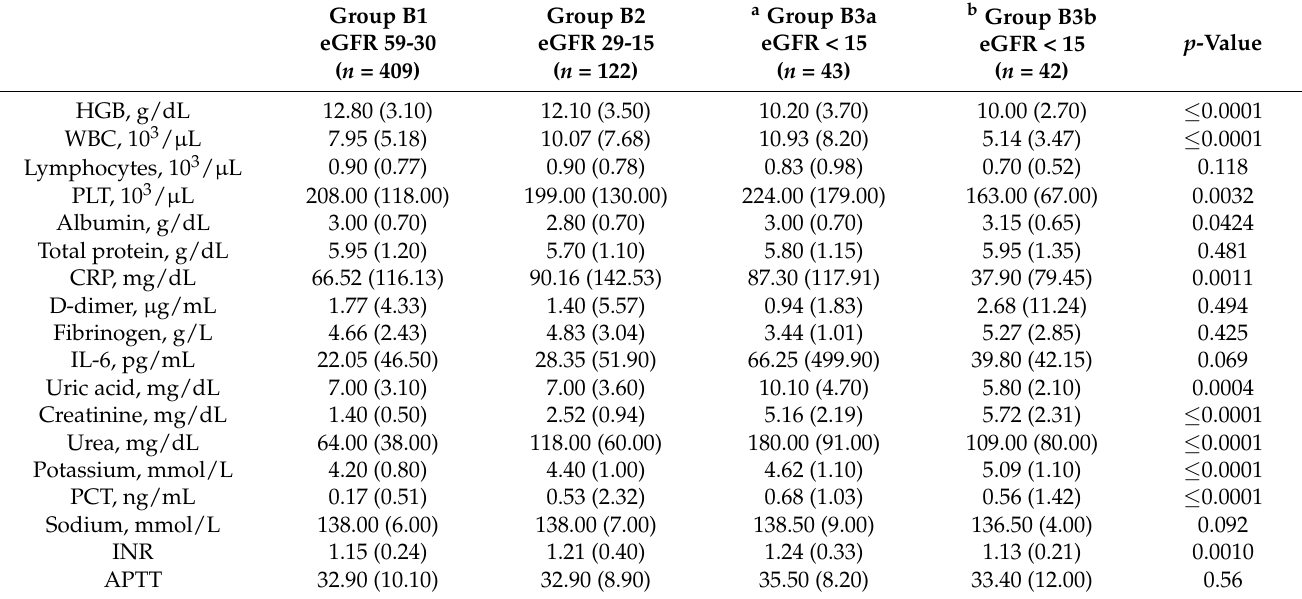
Table 4. Laboratory values of patients with eGFR < 60 mL/min/1.73 m 2 grouped according to eGFR value at